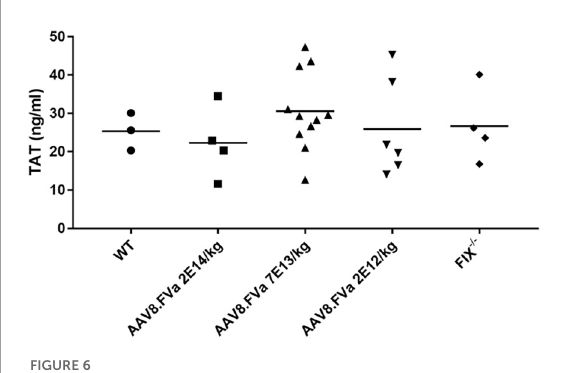
FIGURE6 Evaluate the risk of thrombosis after AAV8/hFVa treatment by detection of the TAT complexes. TAT complexes were measured via ELISA from platelet-poor citrated plasma collected as a terminal puncture of the inferior vena cava at 20 weeks after AAV8/hFVa vector administration when the FIX - / -- mice were killed. Age-matched WT and untreated hemophilia B mice served as the controls.